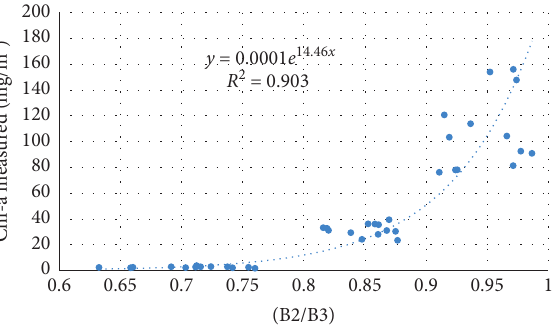
Figure 8: Regression between the Sentinel 2 band index and measured Chl-a, using the B2/B3 model.